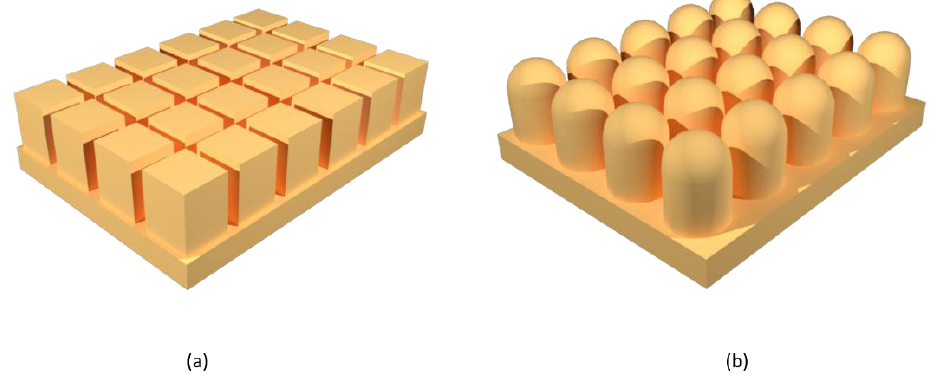
Figure 5. Representation of ( a ) flat-top and ( b ) semicircular structures.